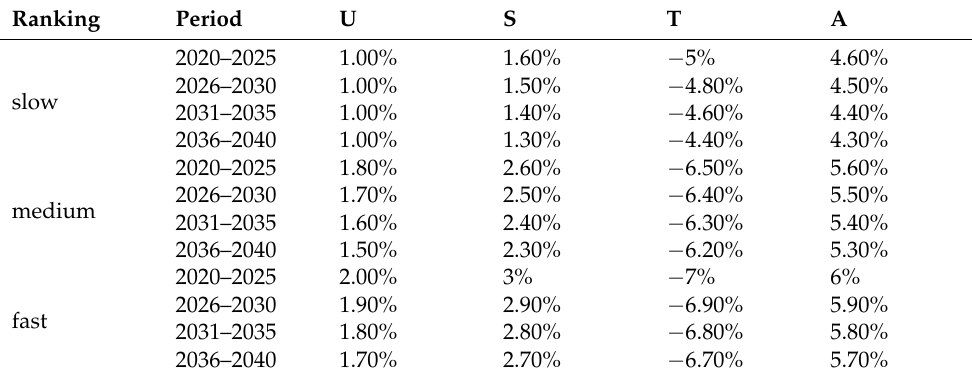
Table 8. Estimated change rates of various driving factors of social